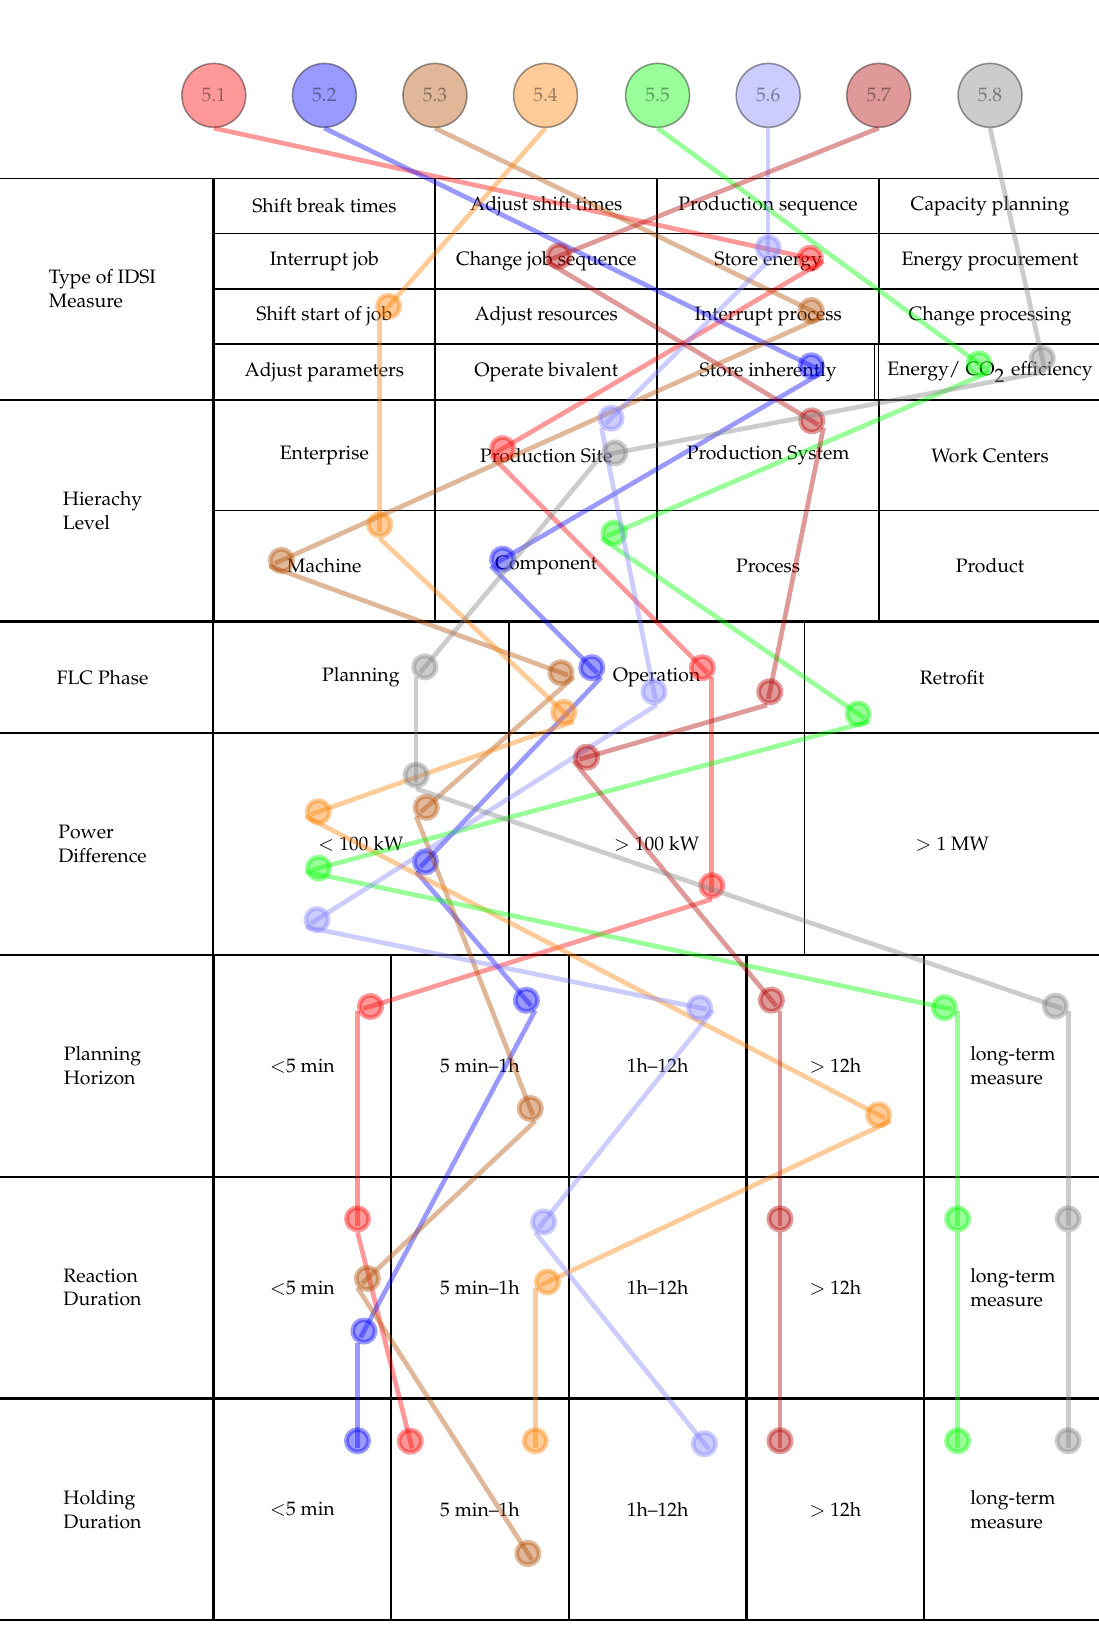
Figure 8. Categorisation of different IDSI measures according to the presented methodology. 5.1— Hybrid energy storage system, 5.2—Electrically heated oil bath, 5.3—Cleaning machine, 5.4—Machine tool, 5.5—Hydraulic pressure system, 5.6—Cooling supply system, 5.7—Production system, 5.8— PV